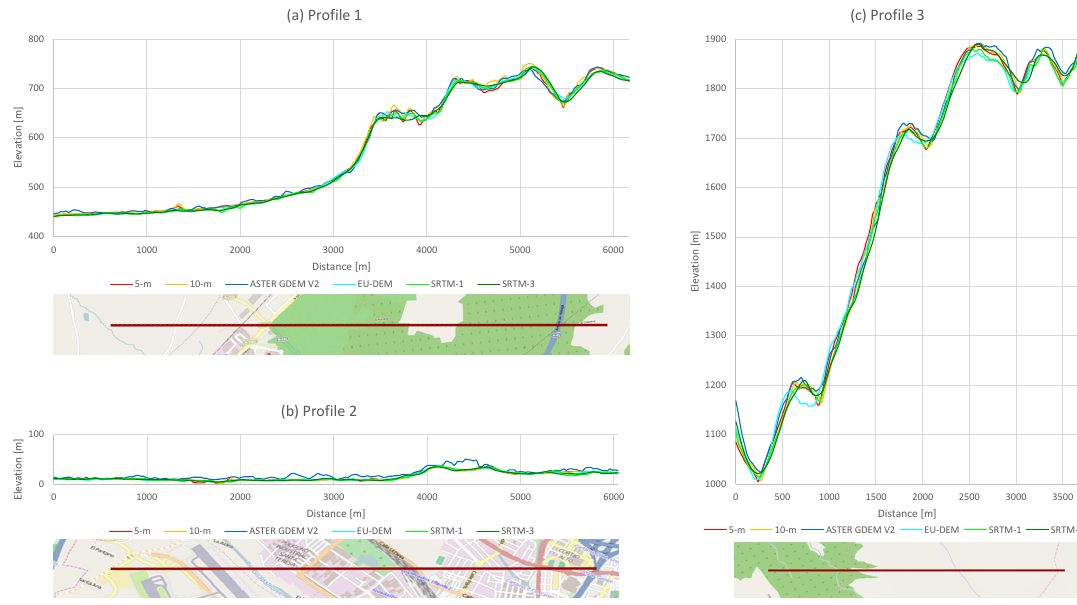
Figure 4. Elevation profiles of the DEMs that are used for the comparison. ( a ) Profile 1; ( b ) Profile 2; ( c ) Profile 3. Map: